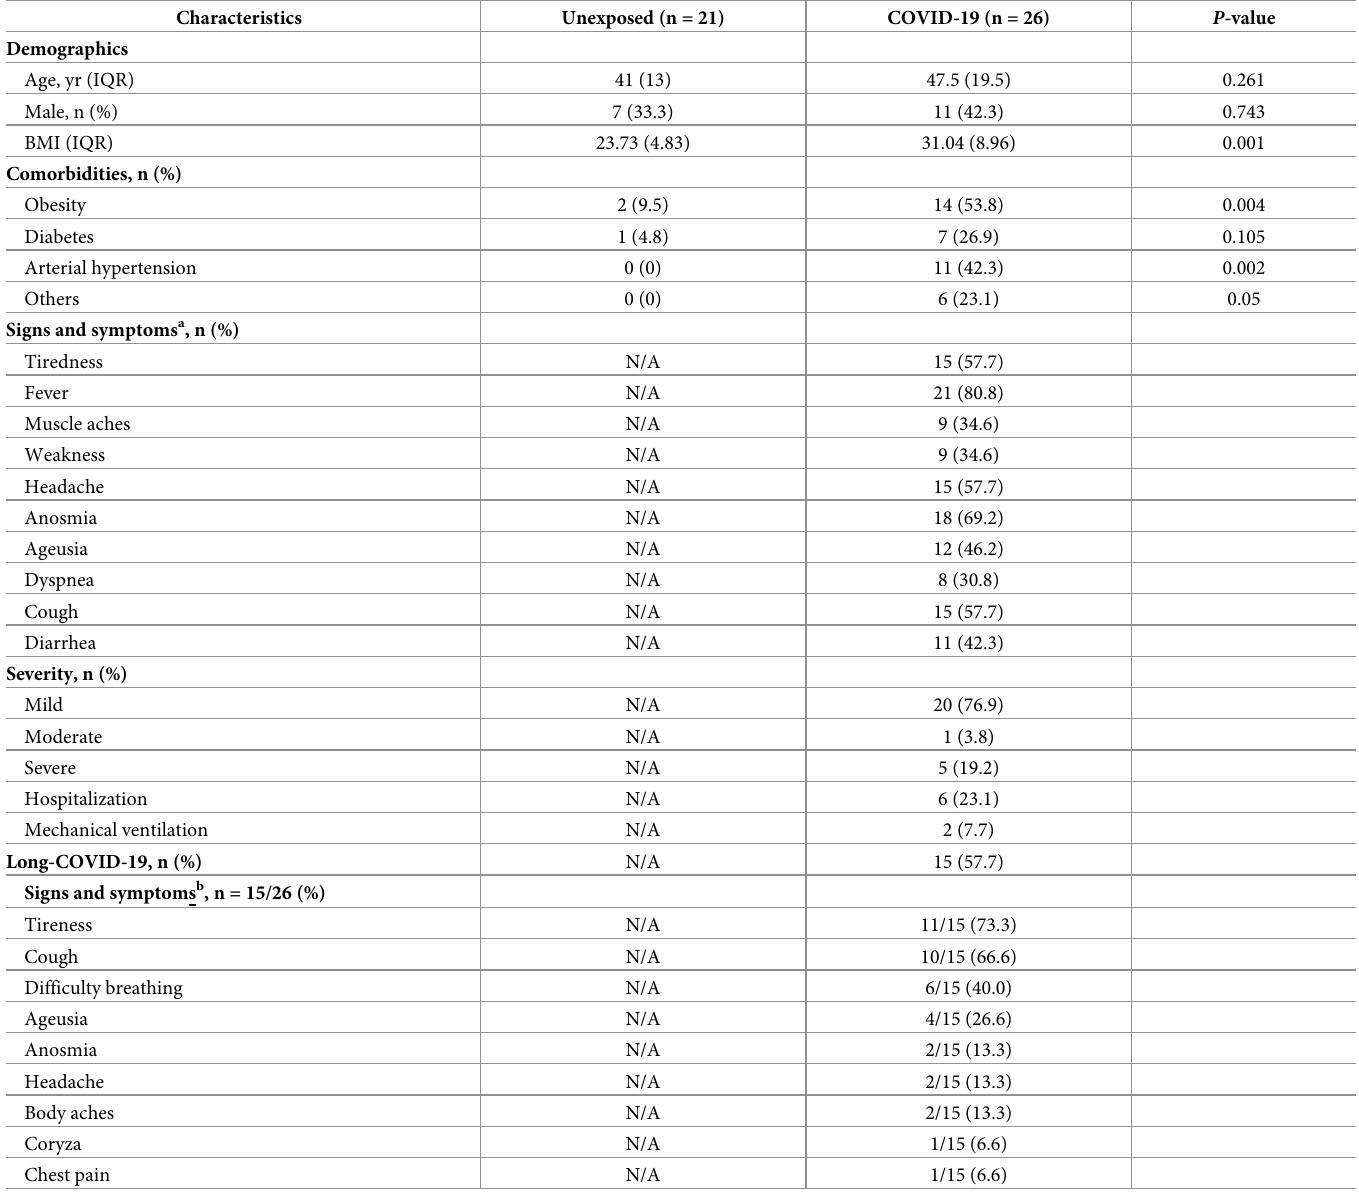
Table 1. Sociodemographic and clinical characteristics of the study population.